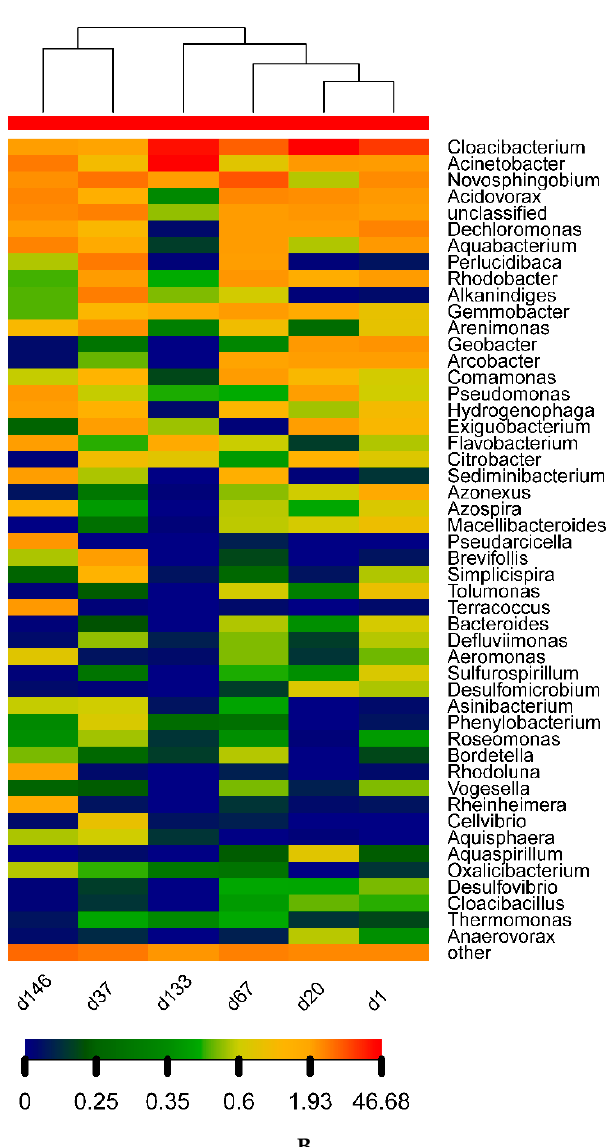
Figure 5. Community structure and distribution of samples ( A : At class level by Circos analysis; B : At genus level by heatmap).